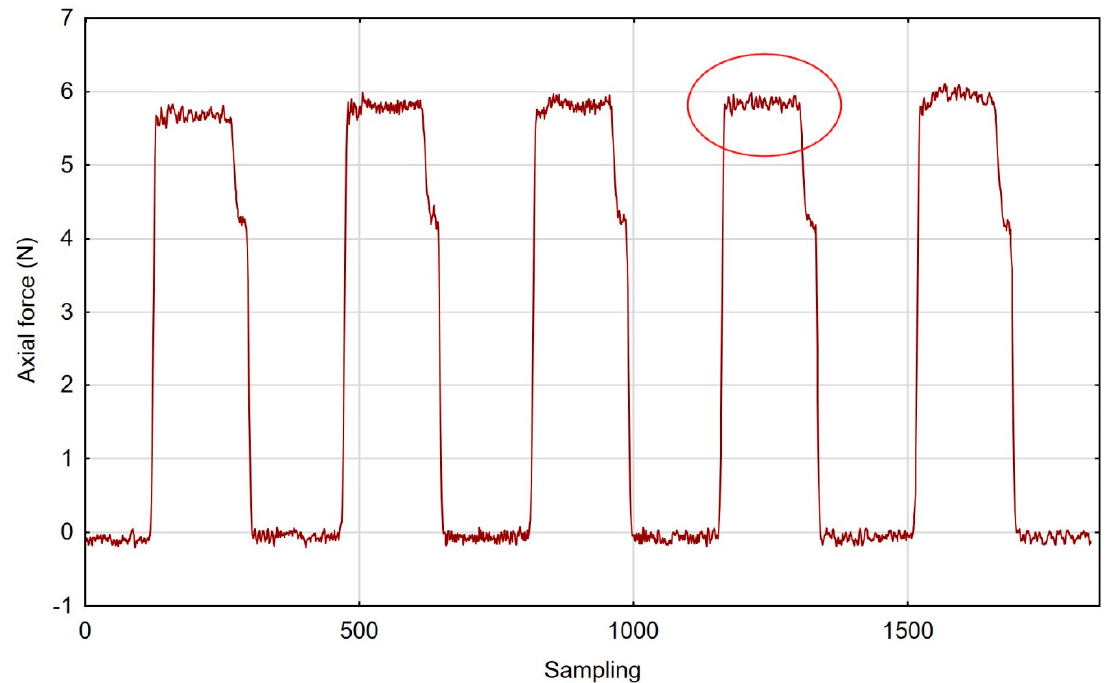
Figure 6. Axial force during brush treatment with the pink fibre tool and “low” spring in the offset adjustment sleeve.